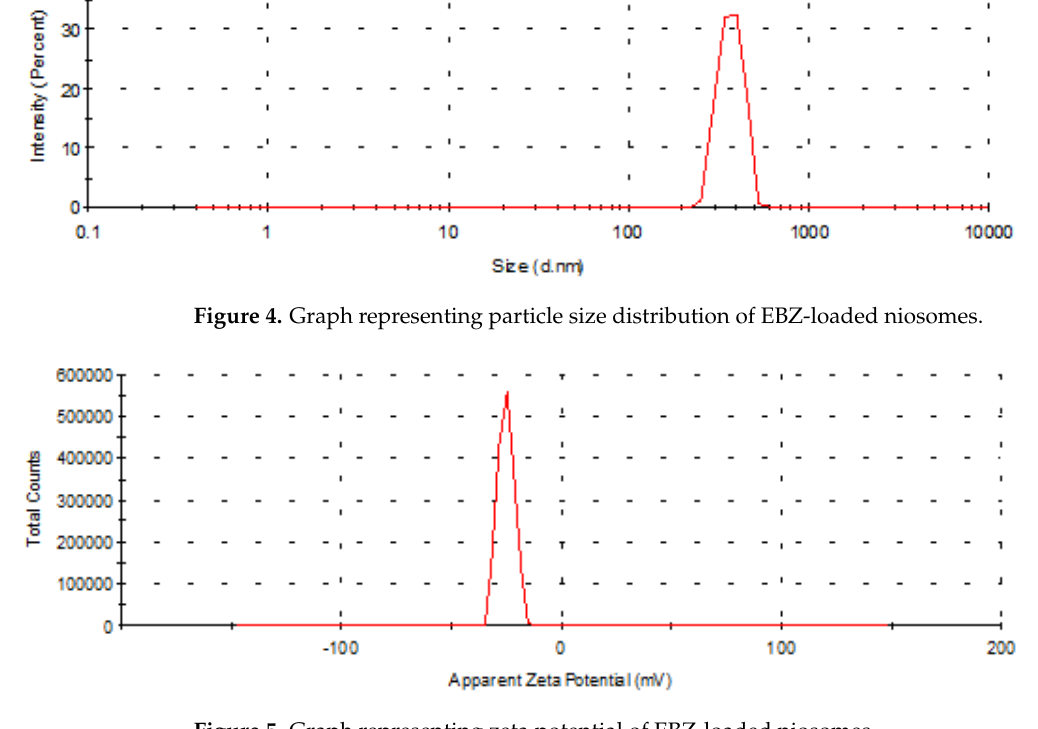
Figure 5. Graph representing zeta potential of EBZ-loaded niosomes.